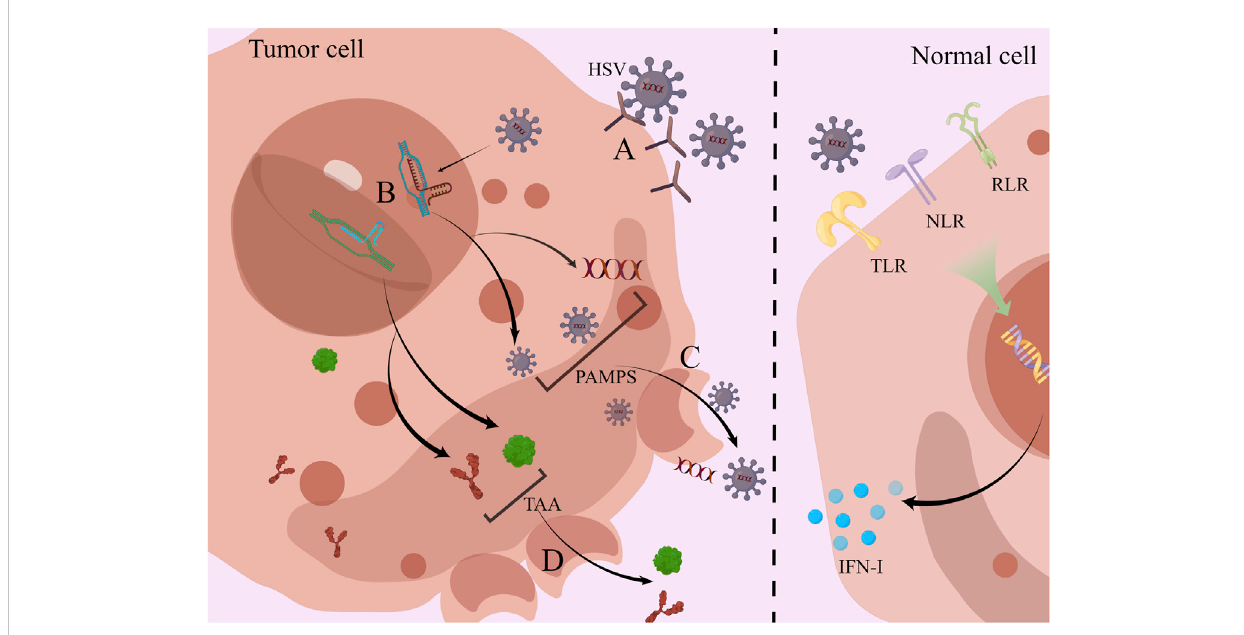
FIGURE 2 HSV directly infects and lyses tumor cells; normal cells activate antiviral effects via PRR. (A) HSV enters cells via HVEM or glycoproteins in the envelope. (B) Inside thenucleus, HSV uses cells for self-replicationand value-added, producing large amounts of viralnucleicacids, viral capsidproteins, and progeny viral particles. (C) Viral proliferation leads to cell lysis, and PAMPS are released into theoutside of thecell. (D) Along with cell lysis, TAA isalso released whichis highly expressed intumor cells. In contrast to tumor cells, normal cells rely on PRRs such as TLR, NLR, and RLR to activate antiviral mechanisms and secrete in fl ammatory factors such as type I IFN to kill the